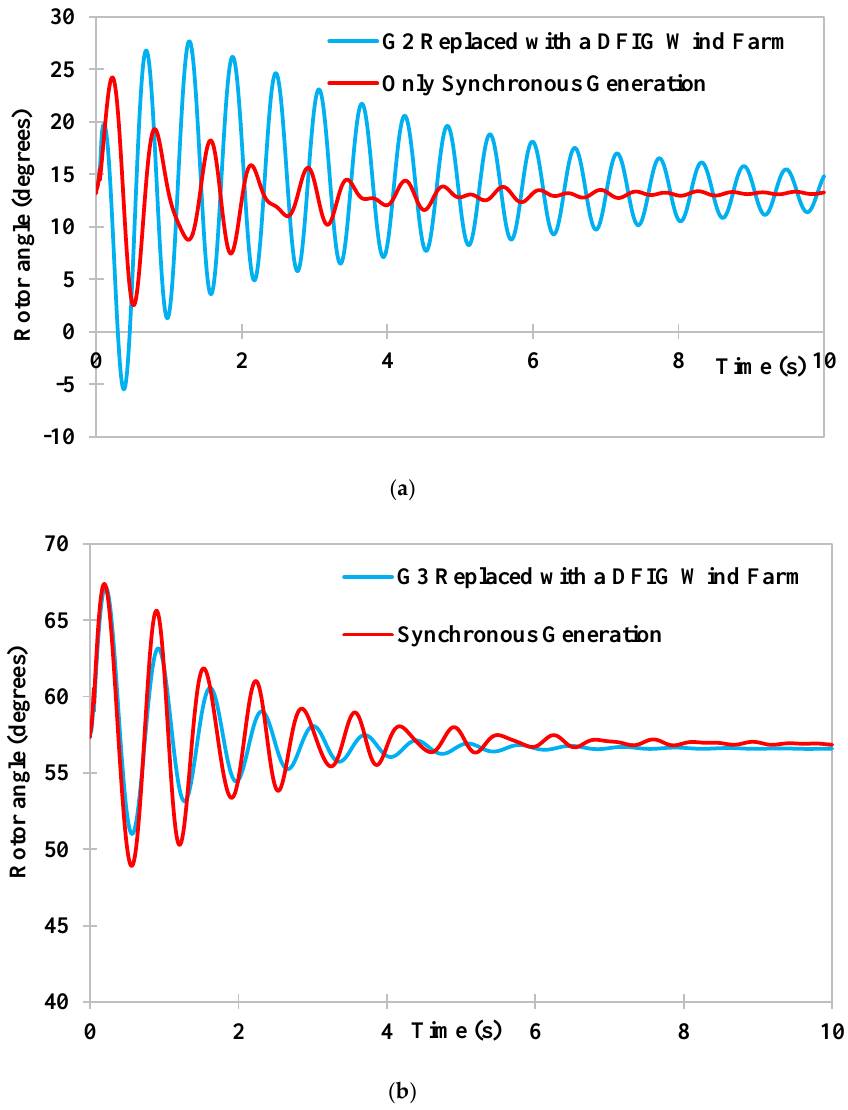
Figure 3. Rotor angle stability with wind generation; ( a ) G3 rotor angle following the fault for scenario-1, ( b ) G2 rotor angle following the fault for scenario-2. DFID—doubly-fed induction generator.